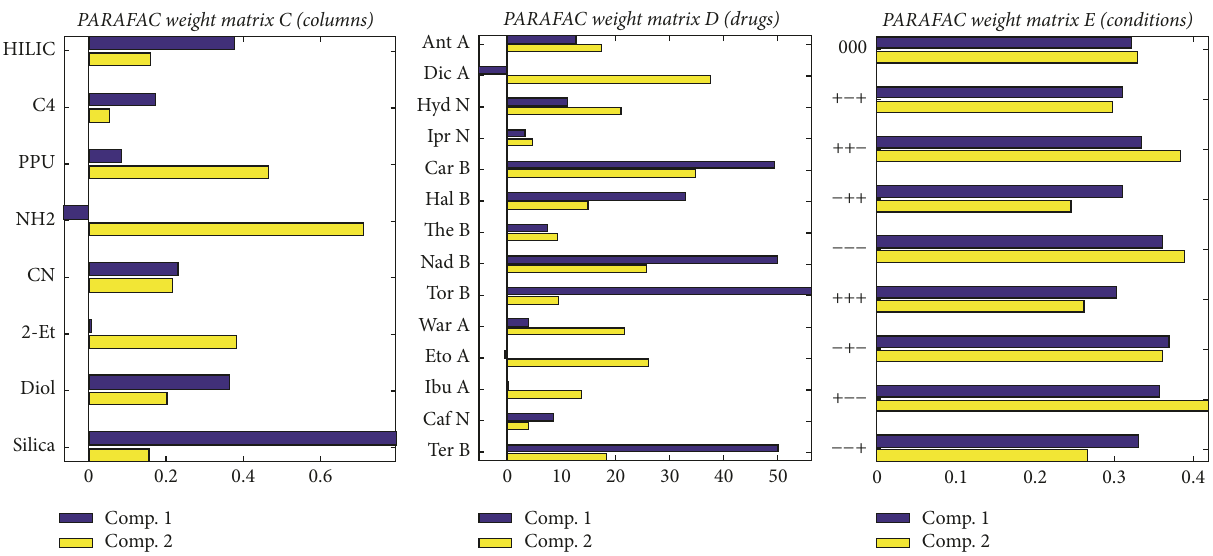
PARAFAC weight matrix C (columns) PARAFAC weight matrix D (drugs) PARAFAC weight matrix E (conditions)